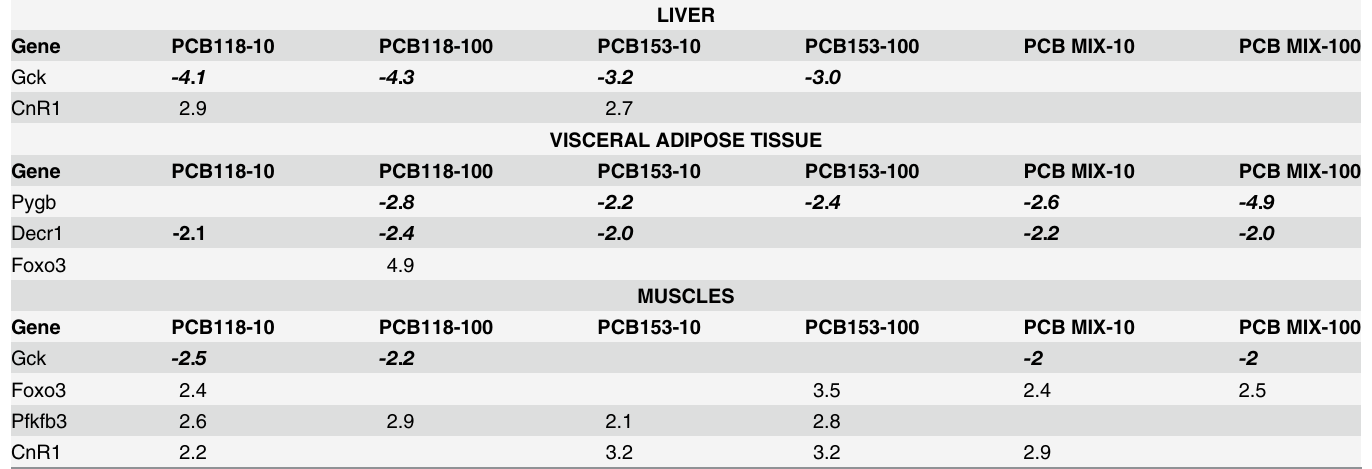
Table 5. Genes involved in glucose homeostasis and insulin signaling based on microarray analyses.